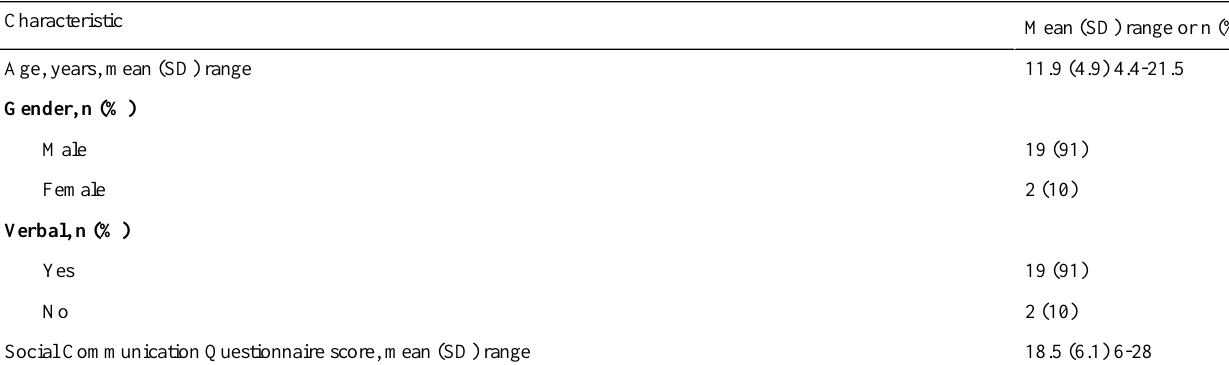
Table 1. Demographics of users (N=21).